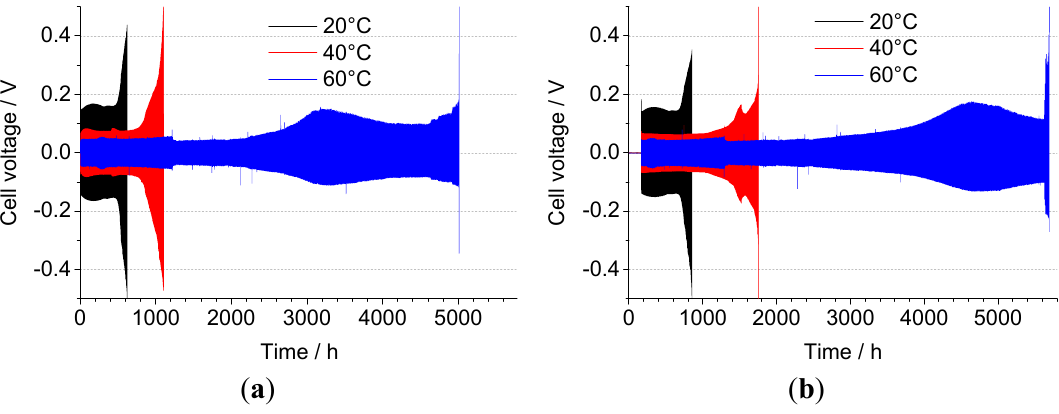
Figure 4. Galvanostatic cycling of Li/0.1 LiTFSI-0.9 Pyr 20, 40 and 60 °C. ( a ) Without thermal conditioning; ( b ) including one week of thermal conditioning at open circuit voltage and cycling temperature. Separator: Whatman GF-F.